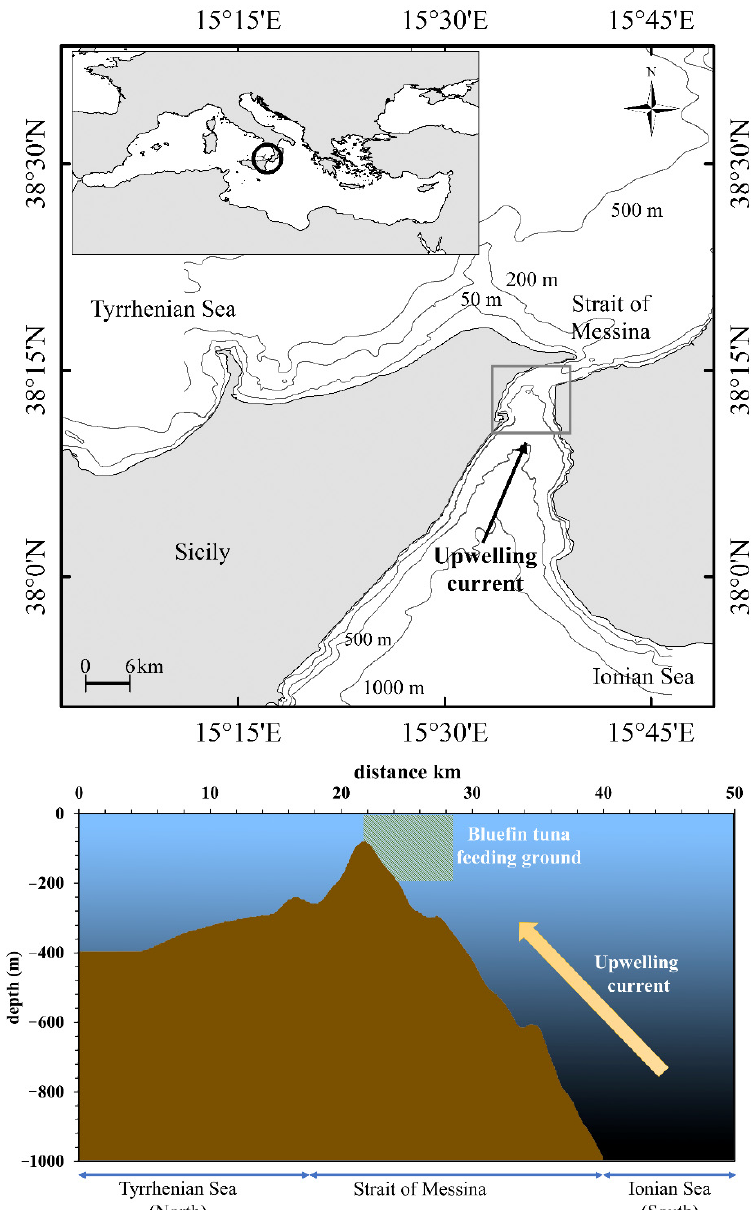
Figure 1. Study area located in the Strait of Messina (central Mediterranean Sea), depth profile of the bottom and direction of the upwelling current. The location of the bluefin tuna feeding ground is also